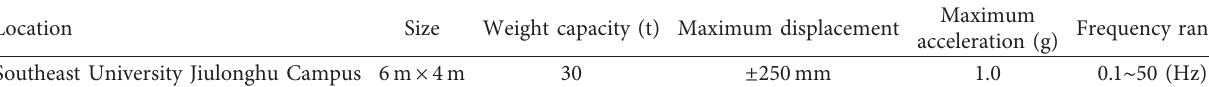
Table 1: The parameters of the shaking